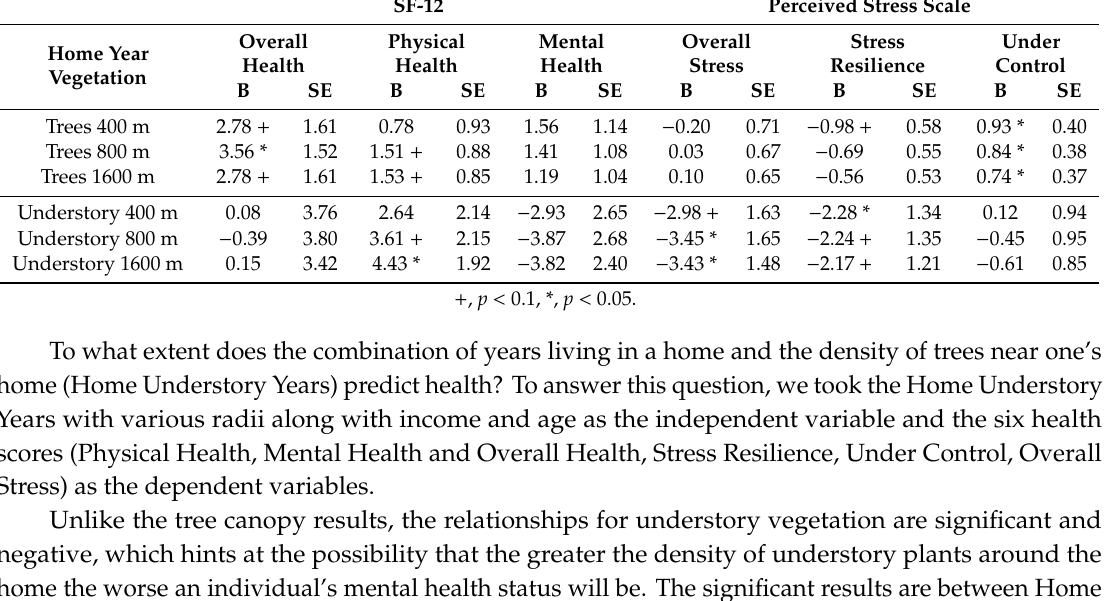
Table 4. Relationship between Nature Exposure around Home and Health Outcomes.